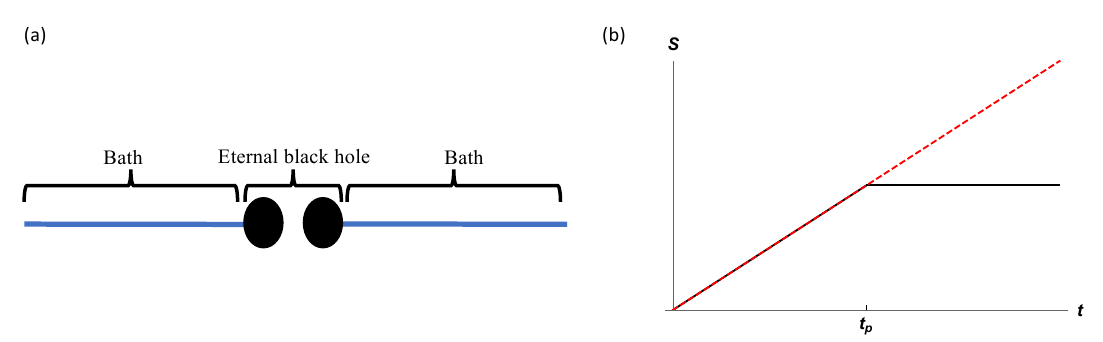
Figure 4 . (a) A schematic illustration of a two-sided eternal black hole coupled to a one-dimensional bath. (b) The evolution of the entanglement entropies of the black hole and the bath in this setup. The black curve represents the evolution of the entanglement entropy of both the black hole and the bath under unitary evolution, and is hence a counterpart of the Page curve for this setup. The red dashed line shows the evolution of the entanglement entropy of the radiation from naive semiclassical calculations, or without including void formation processes, which is a manifestation of the information loss problem in this